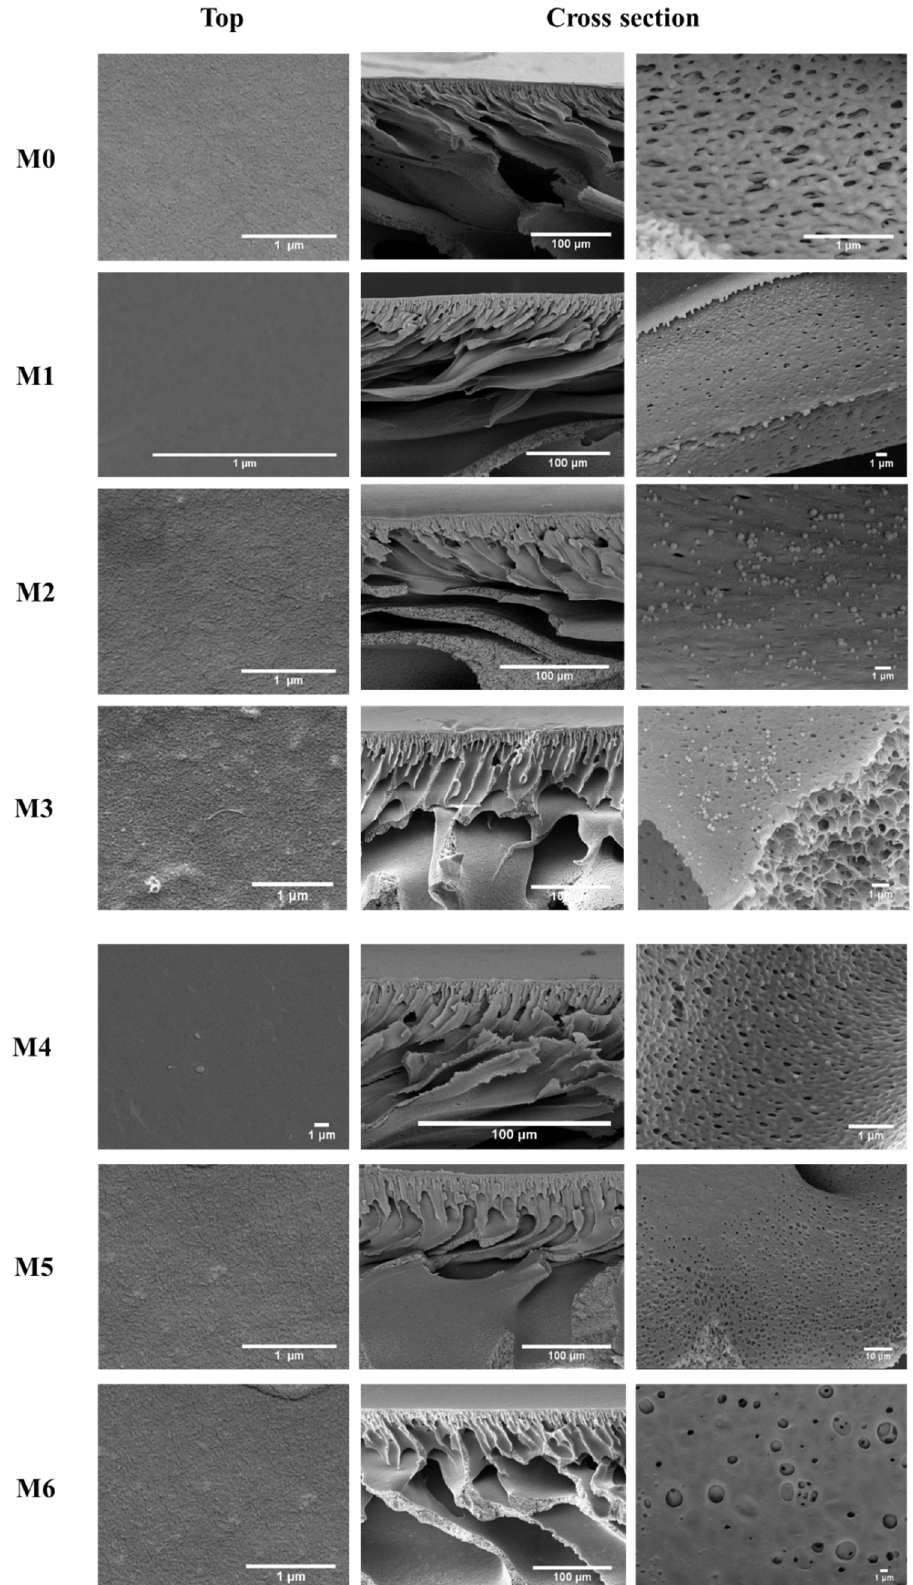
Figure 4. FESEM images of the bare PES, PES/MWCNTs, and PES/GO membranes’ top surfaces and cross-section view.